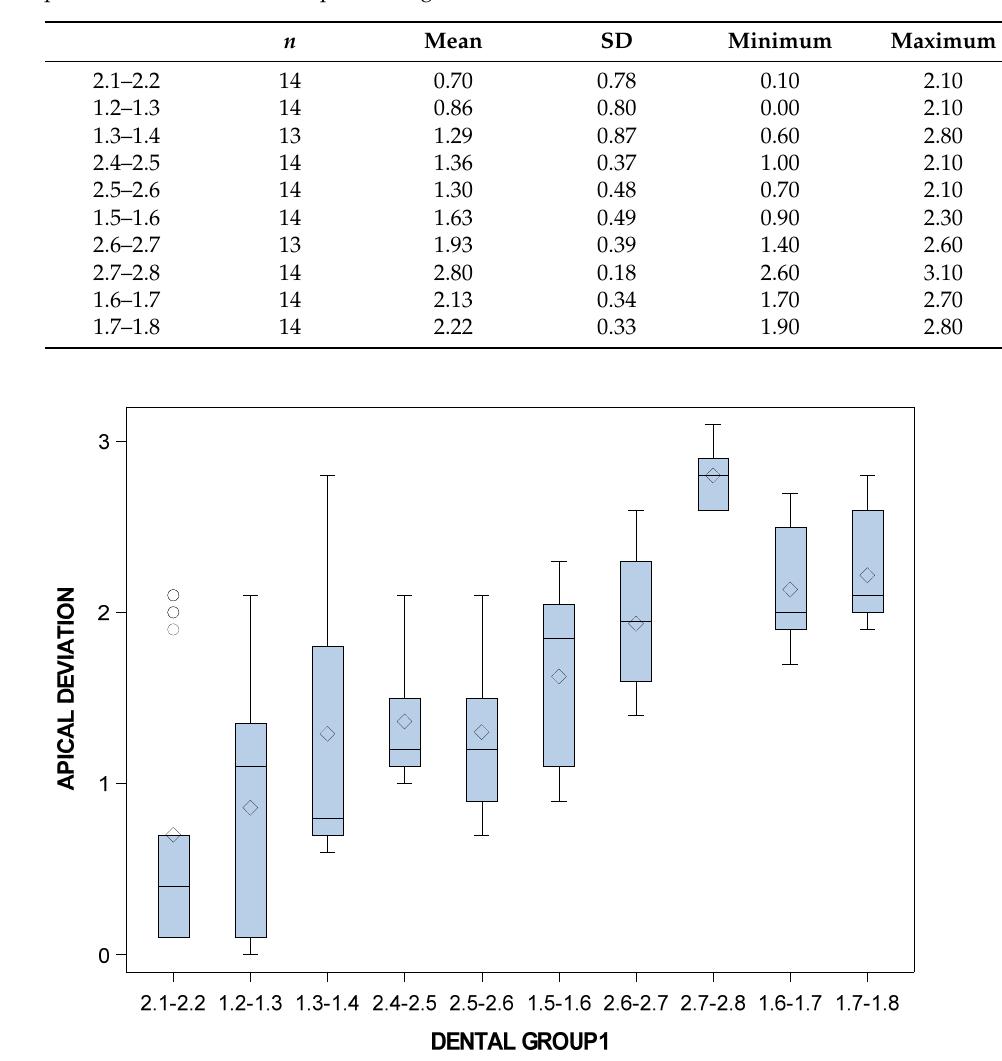
Figure 10. Box plot of the apical end-point deviations of the orthodontic micro-screws in the tooth selected tooth positioning.